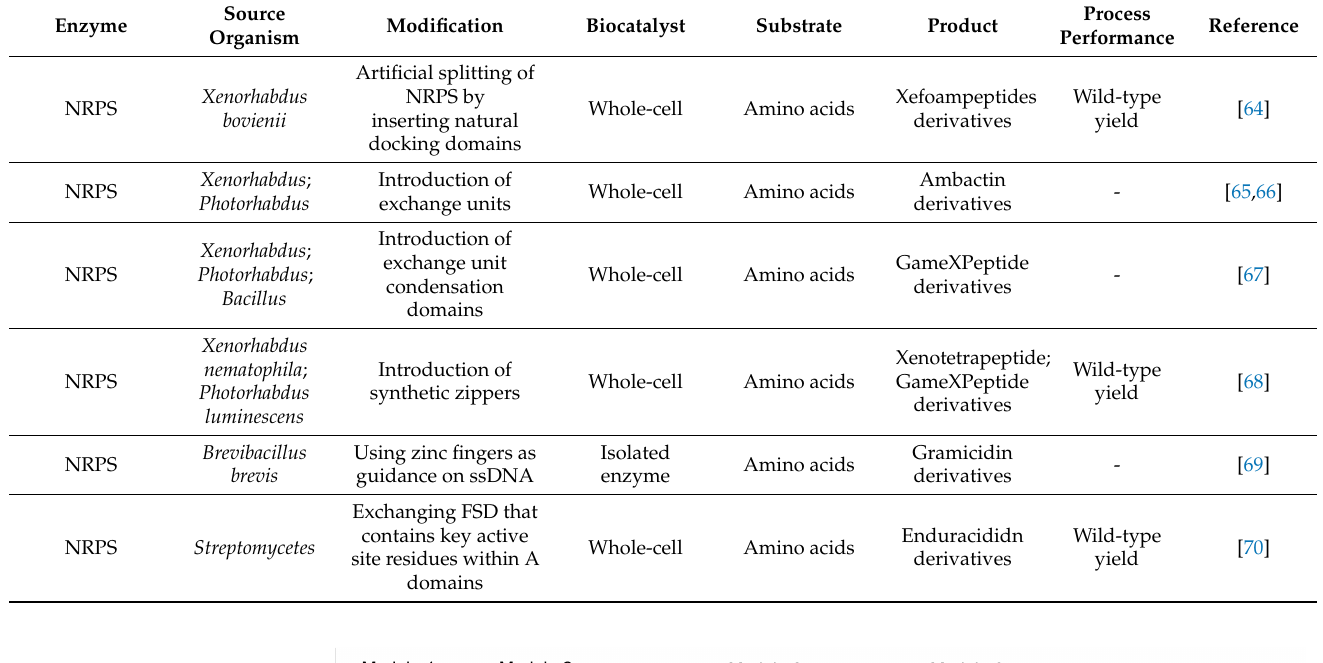
Table 2. Overview of mentioned nonribosomal peptide synthetases (NRPSs).